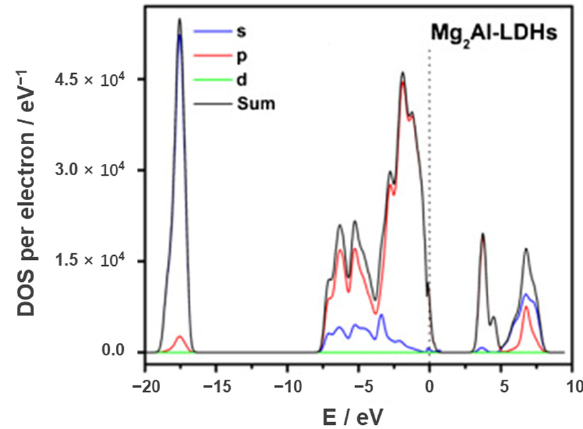
Figure 4. Densities of state for MgAl-LDH [86].